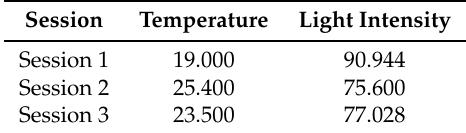
Table 3. Related temperature and light intensity